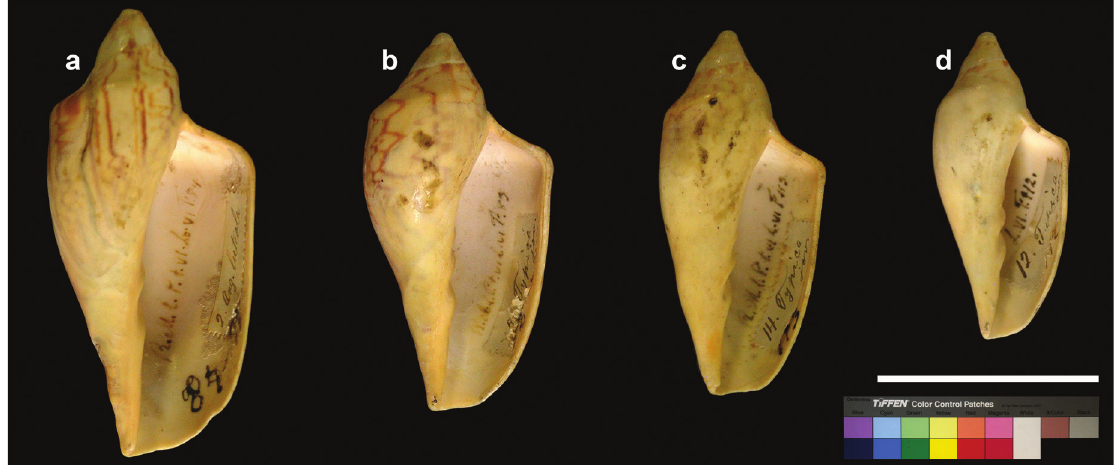
Figure 24. Voluta angulata similis , specimens figured by Lahille (1895). See Table 8 for references. Scale bar: 5 cm.